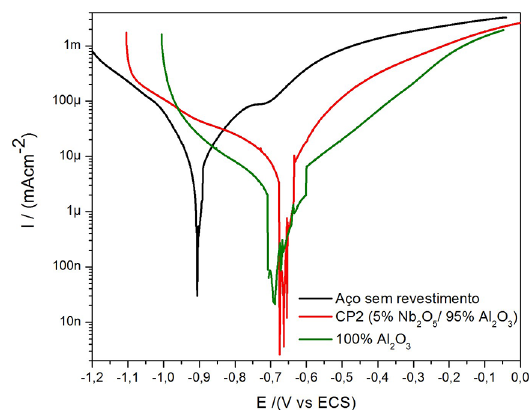
Figure 9. Polarization curves for AISI 1020, 3.5% NaCl, at room temperature: a) without coating; b) with the precursor sol coating of mixed Nb O /Al O oxides with nominal values of 5% and 95%; x y 2 3 c) with precursor sol coating of Al O 2